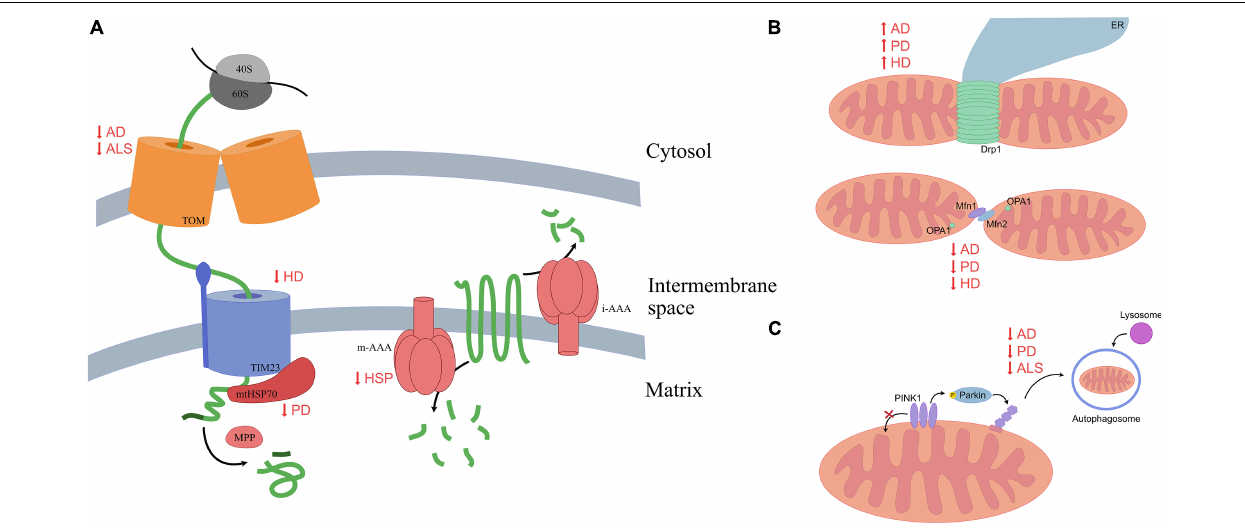
FIGURE 1 | A summary of altered mitochondrial mechanisms in multiple neurodegenerative diseases. (A) Normally, peptides targeted for the mitochondrial matrix move through the TOM complex on the outer mitochondrial membrane, then through the TIM23 complex, where mitochondrial chaperones assist in proper folding and processing enzymes cleave peptides, allowing them to mature. Various proteinopathies alter efficiency of mitochondrial protein import at either the outer or inner membrane, while others are characterized by reduced protease activity. Impaired import results in protein aggregation within mitochondria or the surrounding cytosol, chronically activating mitochondrial quality control mechanisms. (B) Mitochondrial fission is mediated by oligomers of Drp1 that constrict the organelle; fusion of the outer mitochondrial membranes is mediated primarily by Mfn1 and Mfn2, while fusion of the inner mitochondrial membrane is mediated by OPA1. A common characteristic of these neurodegenerative diseases is an increase in fission and a decrease in fusion. This leads to fragmentation of mitochondria, reducing their efficiency. (C) Mitophagy is commonly inhibited in proteinopathies; this leads to accumulation of damaged